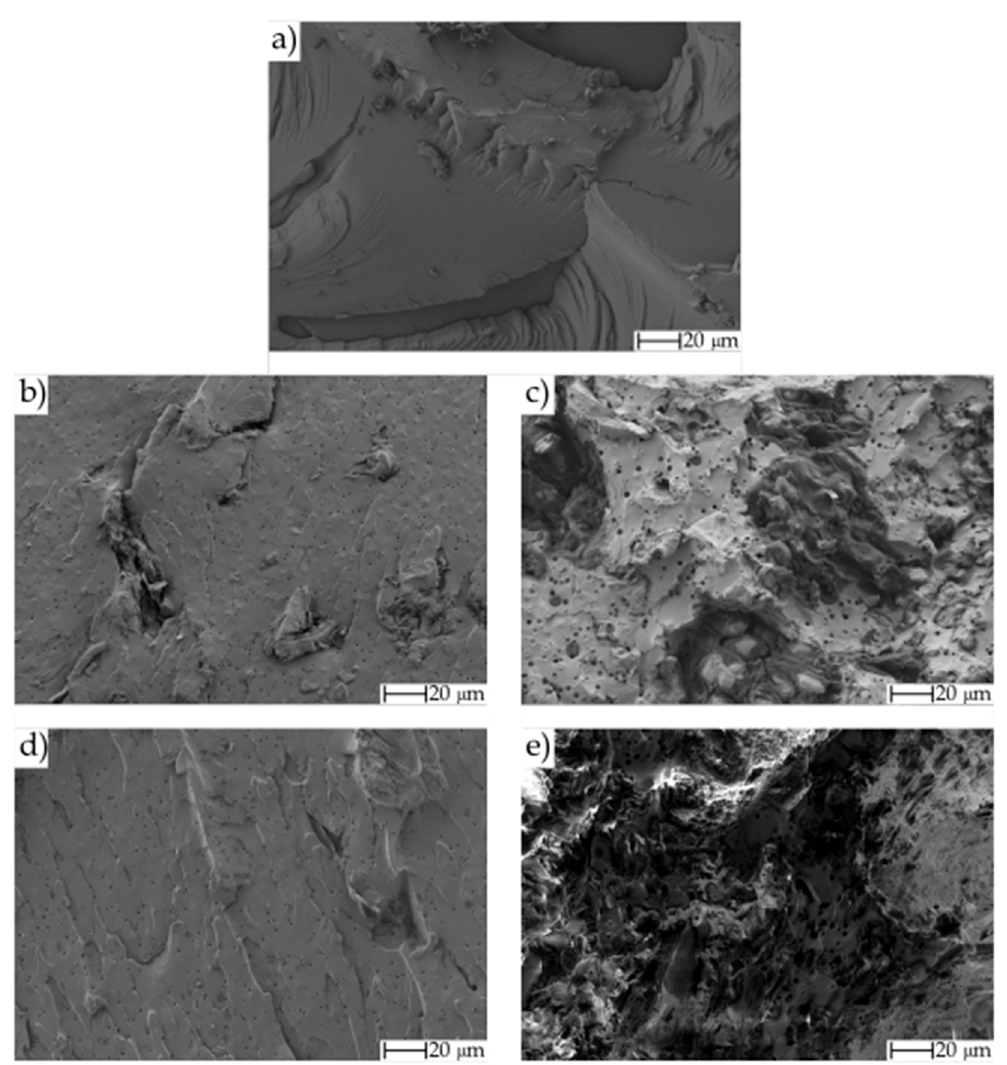
Figure 5. FESEM images at 500 × of impact-fracture surface of: ( a ) BioEP; ( b ) BioEP_10CFF; ( c ) BioEP_40CFF; ( d ) BioEP_10FFF and ( e ) BioEP_40FFF.